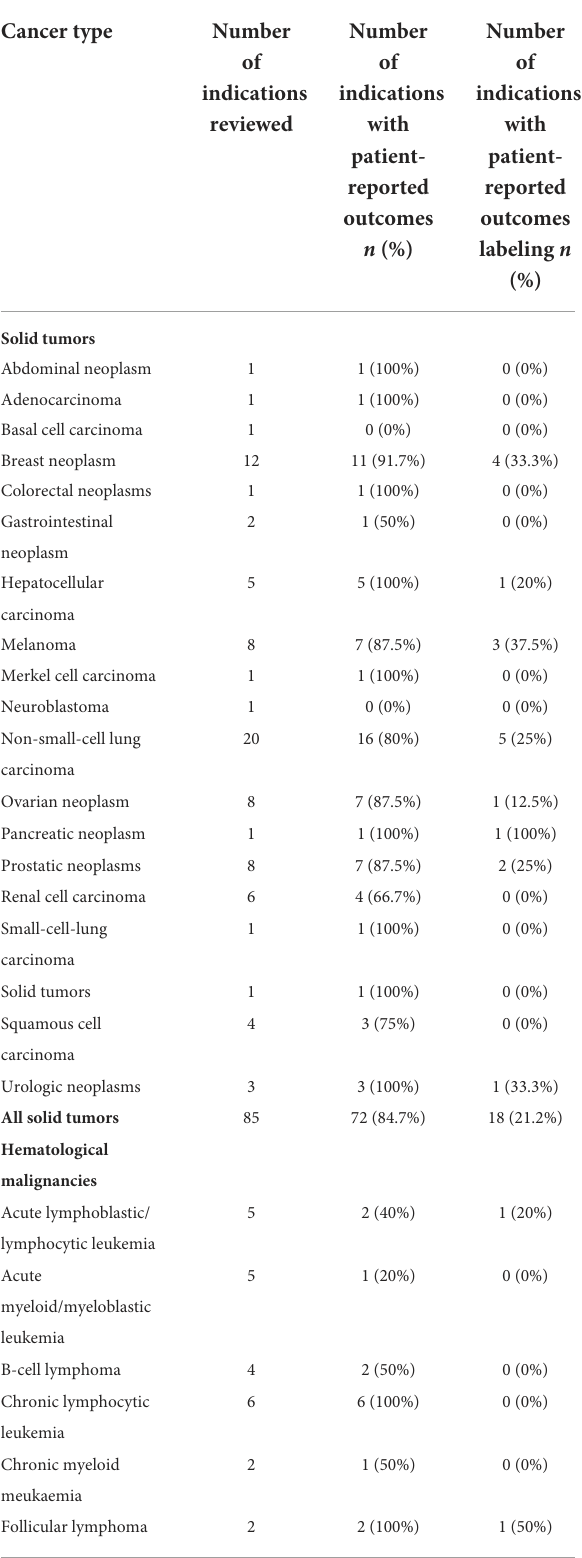
TABLE 1 Summary of patient-reported outcomes and patient-reported outcomes label